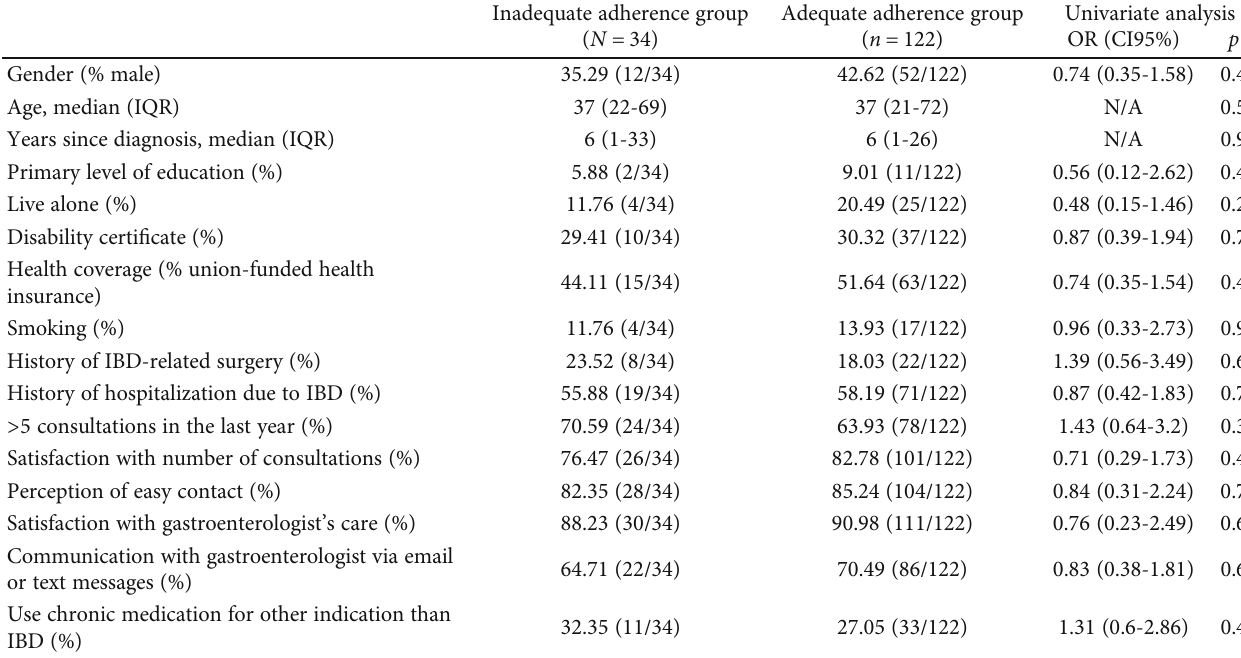
Table 5: Univariate analysis of variables associated with inadequate adherence to biologics.